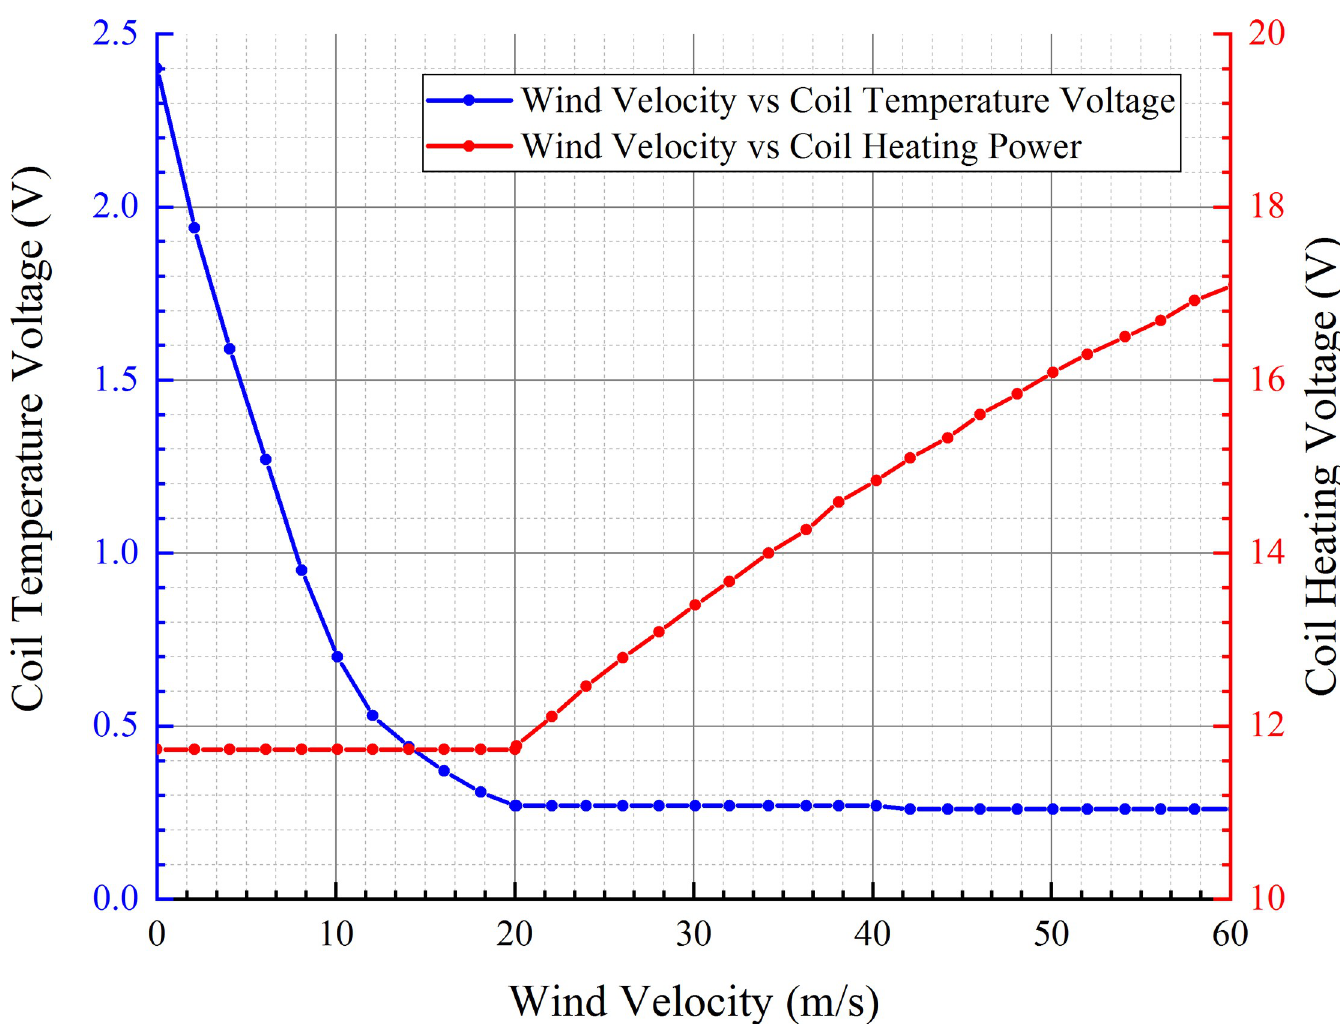
Fig 13. Temperatures and driving voltages of the coil under different wind